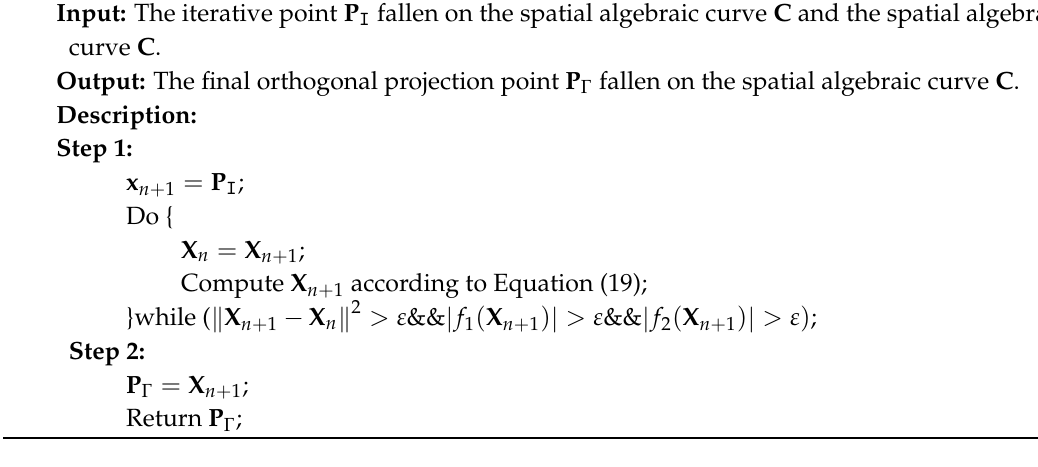
Algorithm 3: Accelerating and geometric correcting method for orthogonal projection onto a spatial algebraic curve